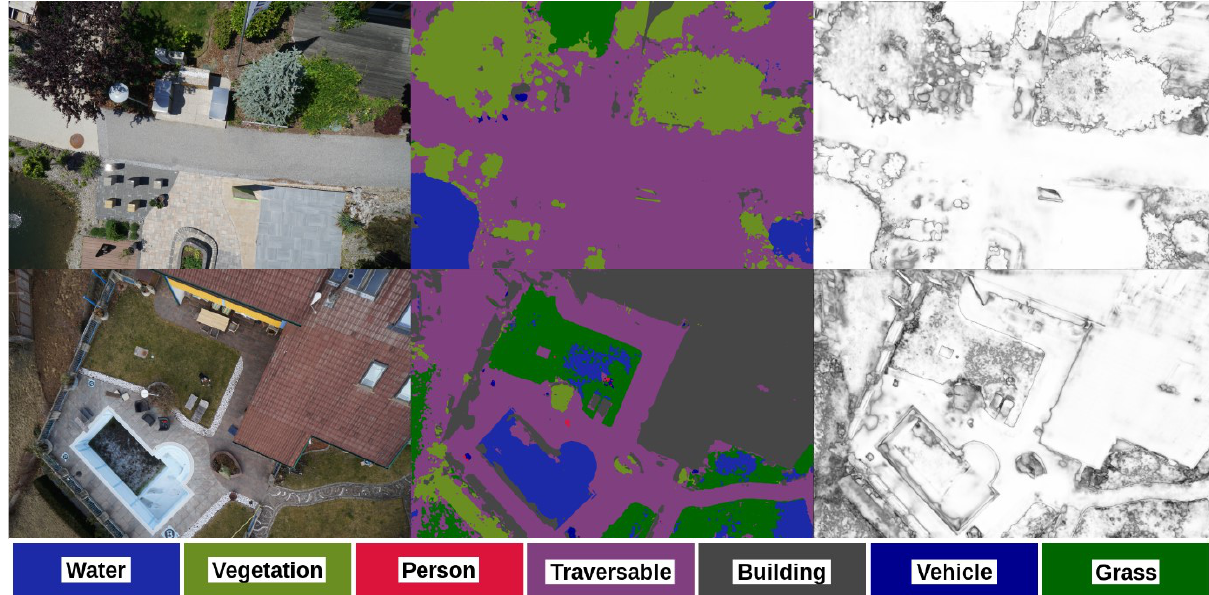
Figure 7. Results on validation images of SemanticDroneDataset (left to right: input image, segmentation results, confidence